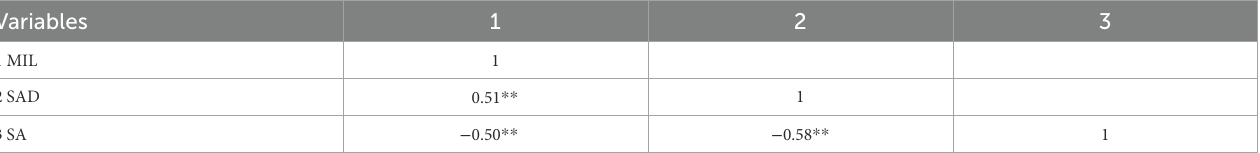
TABLE 2 Inter-correlations of the variables ( n =